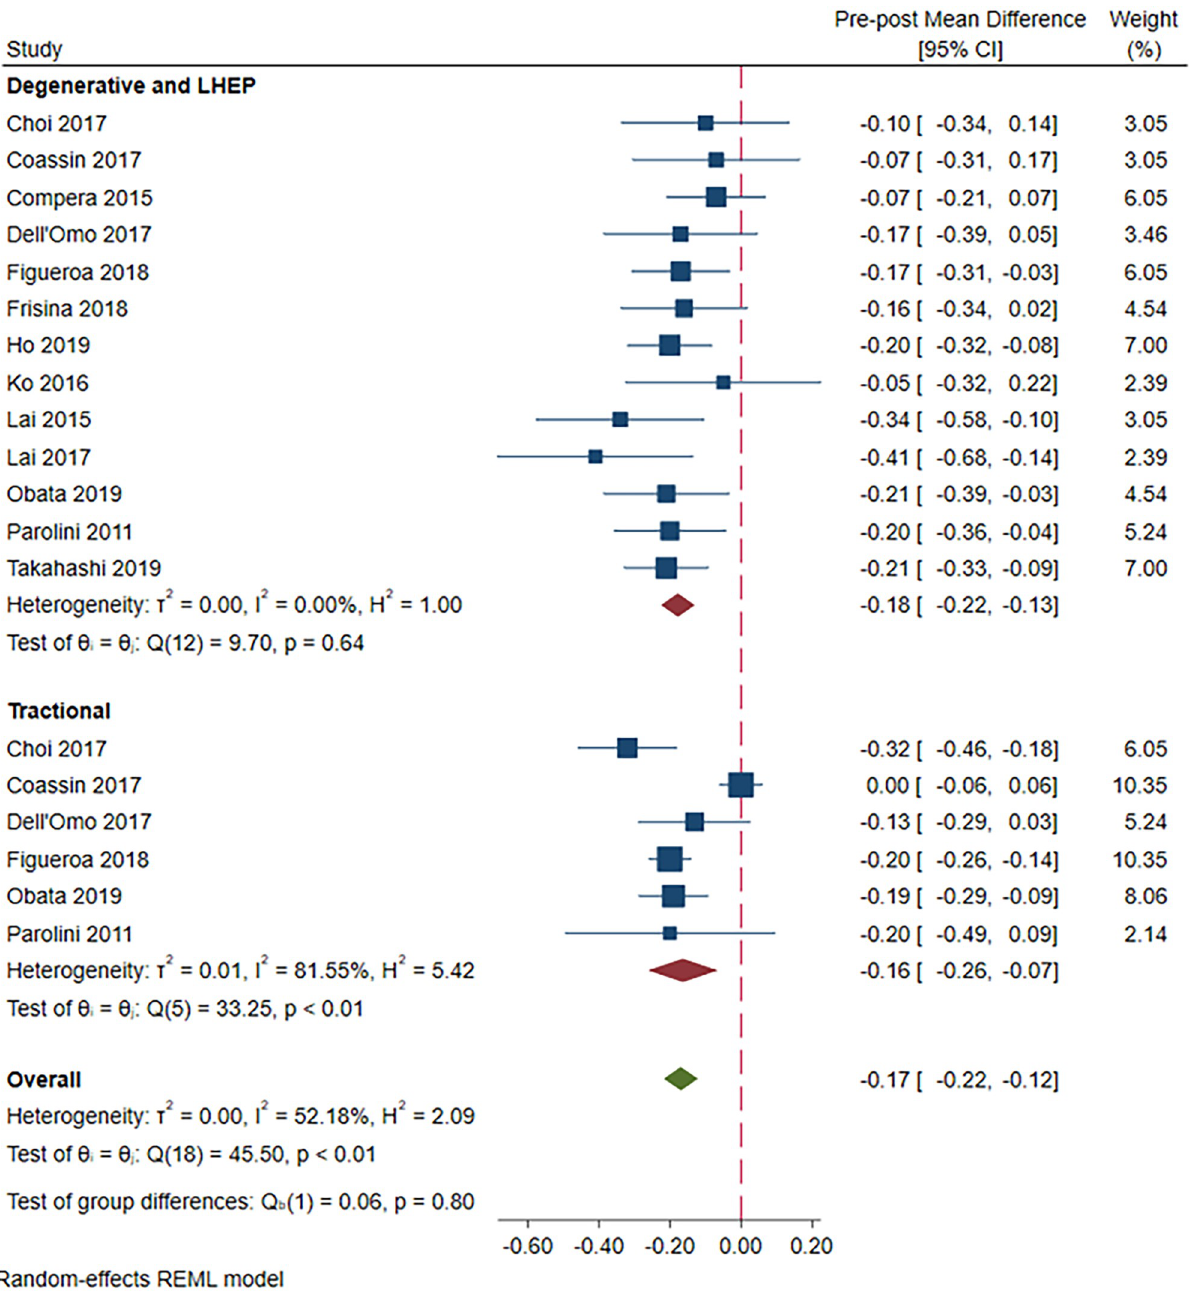
PLOS ONE | https://doi.org/10.1371/journal.pone.0246667 March 5,